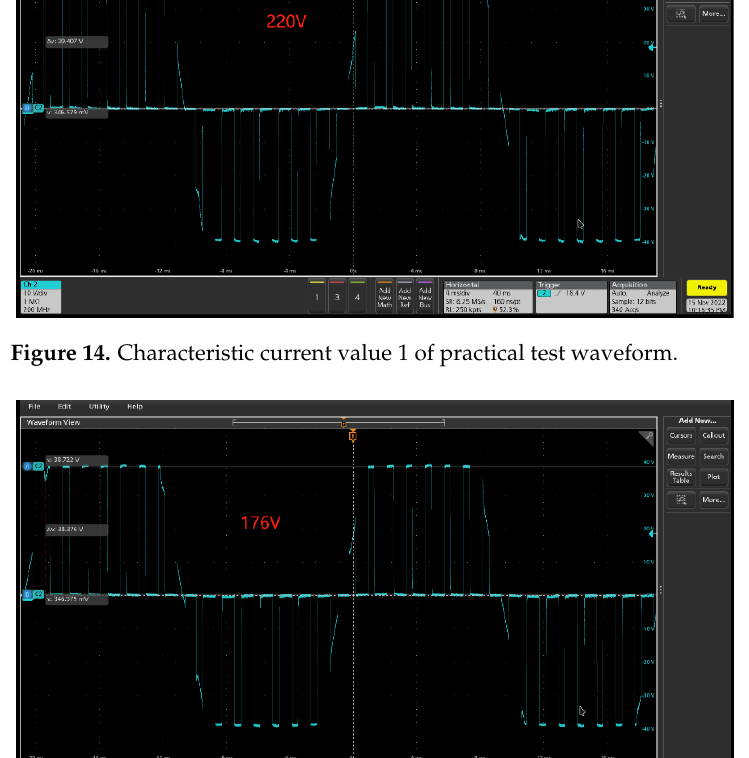
Figure 16. Characteristic current value 3 of practical test waveform. Table 5. Test results of intelligent measurement switches. No. Major Test Items Test Sub-Item Center Frequency Characteristic Code